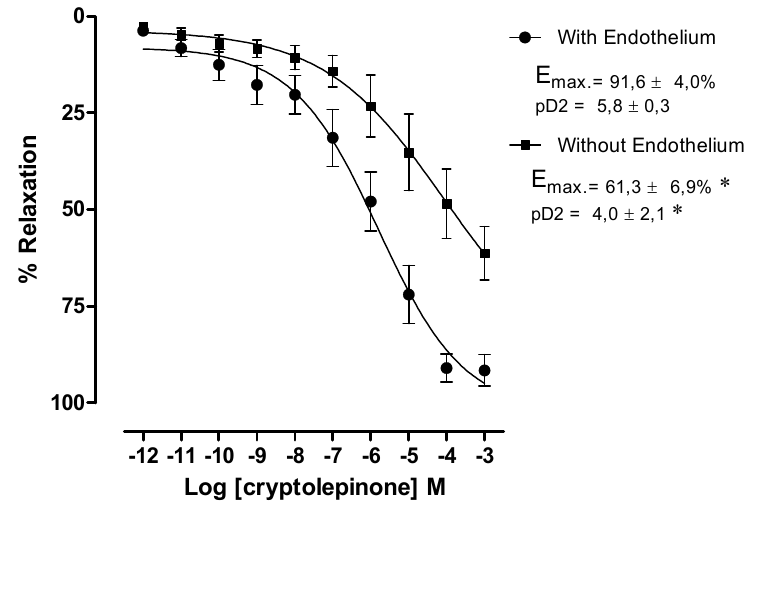
Figure 4. Concentration-response curve of 8 (10 − 12 –10 − 3 M) in cranial mesenteric artery rings isolated from rats with functional endothelium (•) and without functional endothelium ( ■ ) pre-contracted with PHE (1 μ M). Values are expressed as mean ± standard error of mean (SEM), * p < 0.05 compared to the ring with functional